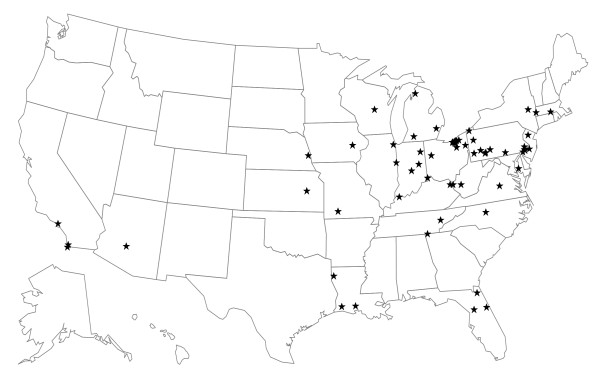
Distribution of the 86 hospitals participating in the registry. Because of proximity, not all hospitals are visible as separate stars.